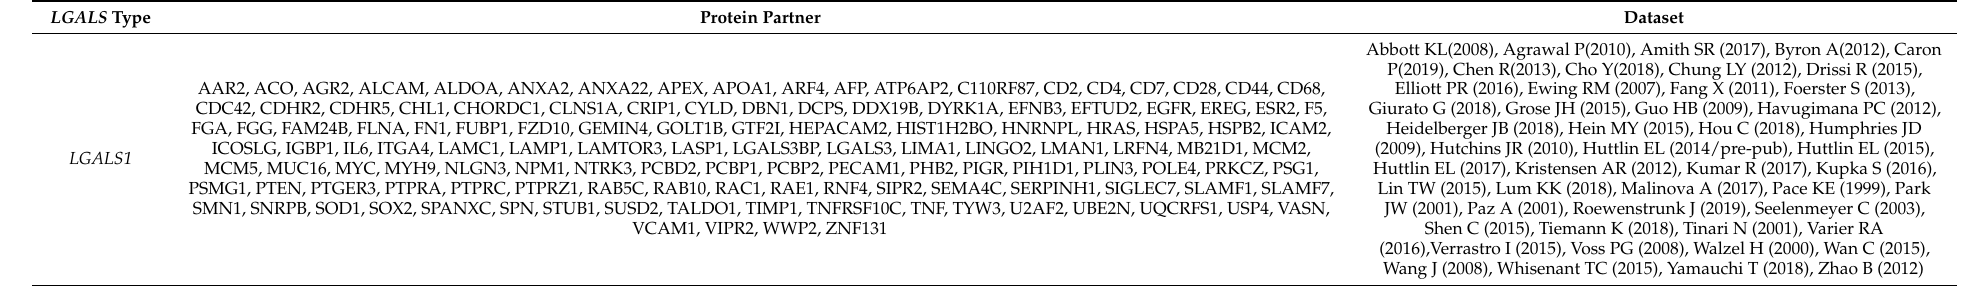
Table 4. Interaction partners of